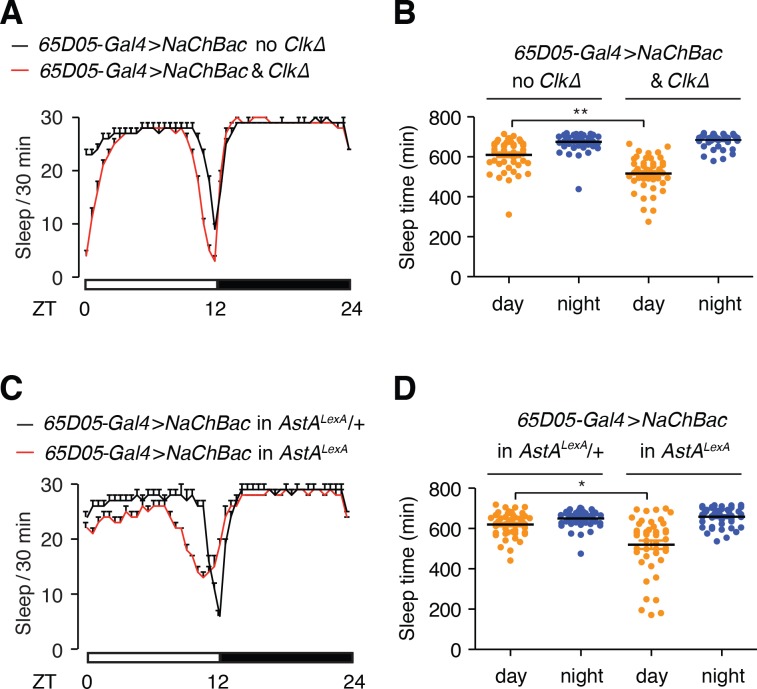
Testing whether Clk and AstA function in sleep in LPNAstA neurons.(A) Sleep profiles of the indicated flies. (B) Quantification of daytime and nighttime sleep of the indicated flies. Error bars, SEMs. n = 48 for all flies. (C) Sleep profiles of the indicated flies. (D) Quantification of daytime and nighttime sleep of the indicated flies. Error bars, SEMs. n = 48 for 65D05-Gal4 > NaChBac in AstALexA/+. n = 46 for 65D05-Gal4 > NaChBac in AstALexA. *p < 0.05, **p < 0.01. Unpaired Student’s t-test of the indicated two groups.